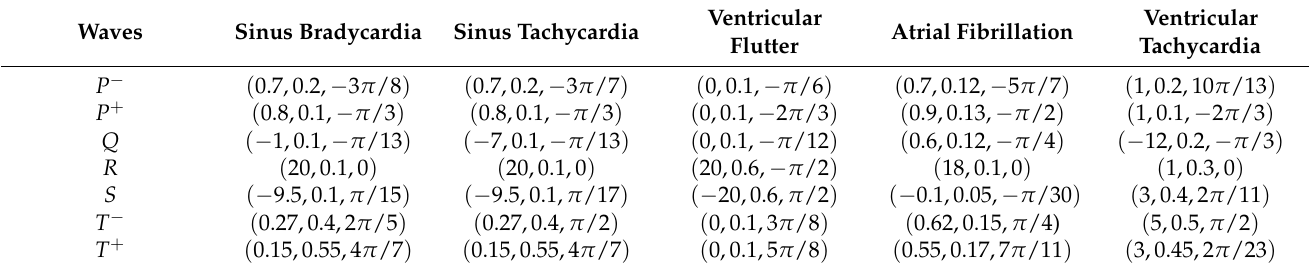
Table 4. Parameter values for the extended dynamical model based on a quasiperiodic motion. The parameters of the Gaussian kernels are expressed by the values of ( a i , b i , θ i ) for each characteris- tic